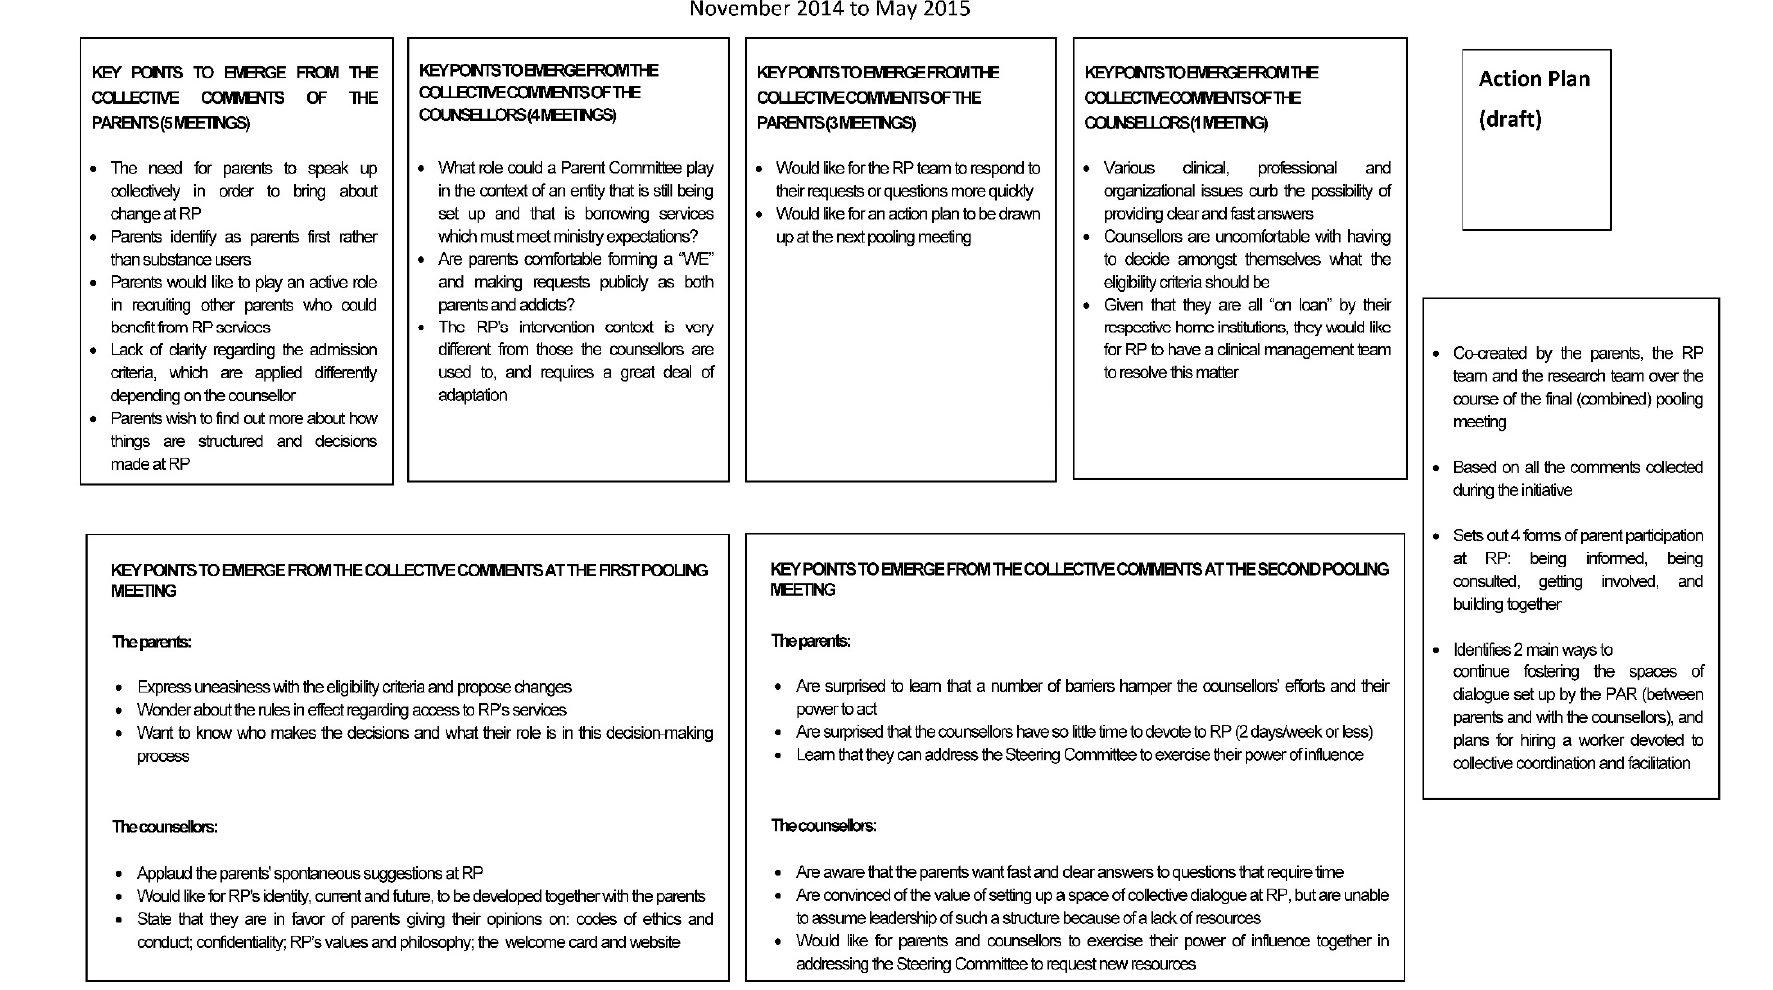
Figure 1. The Figure 1. The initiative.